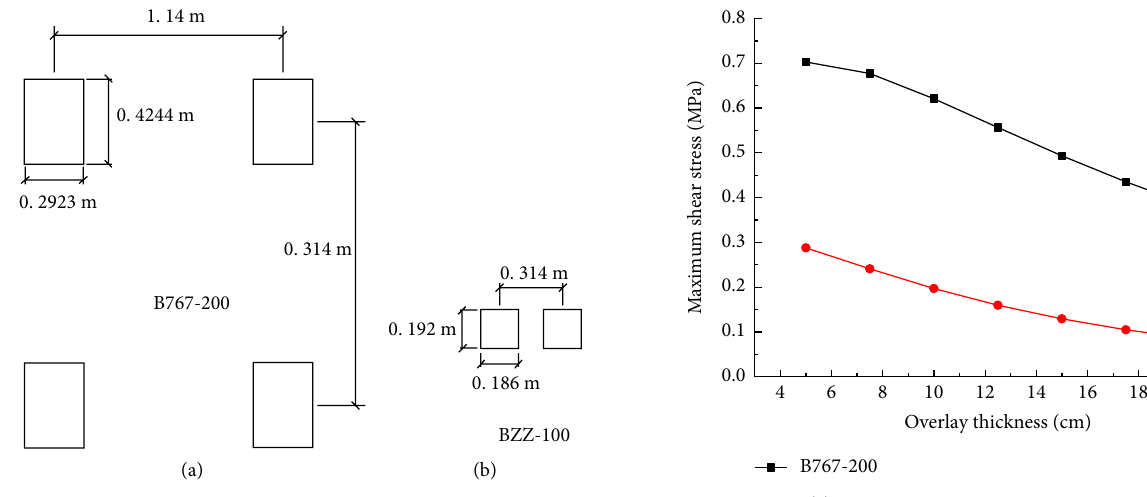
Figure 3: Load layout form: (a) B-767-200, (b)